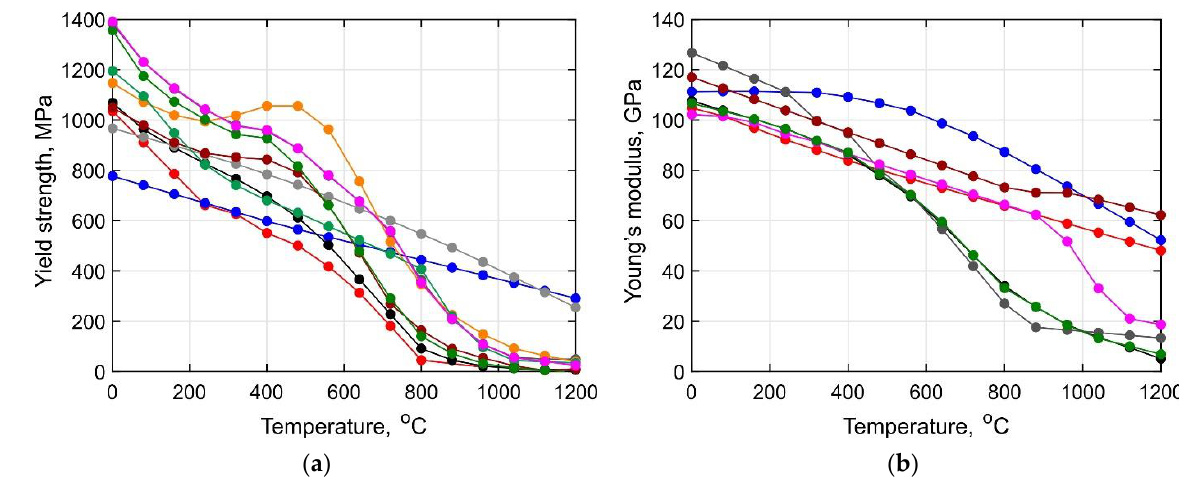
Figure 1. Temperature dependence of the ( a ) yield stress and ( b ) Young’s modulus according to [7,10,25–33].